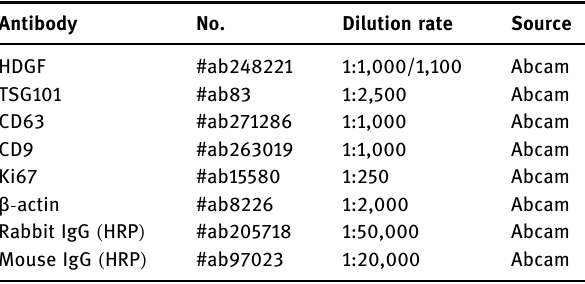
Table 2: Antibodies used in western